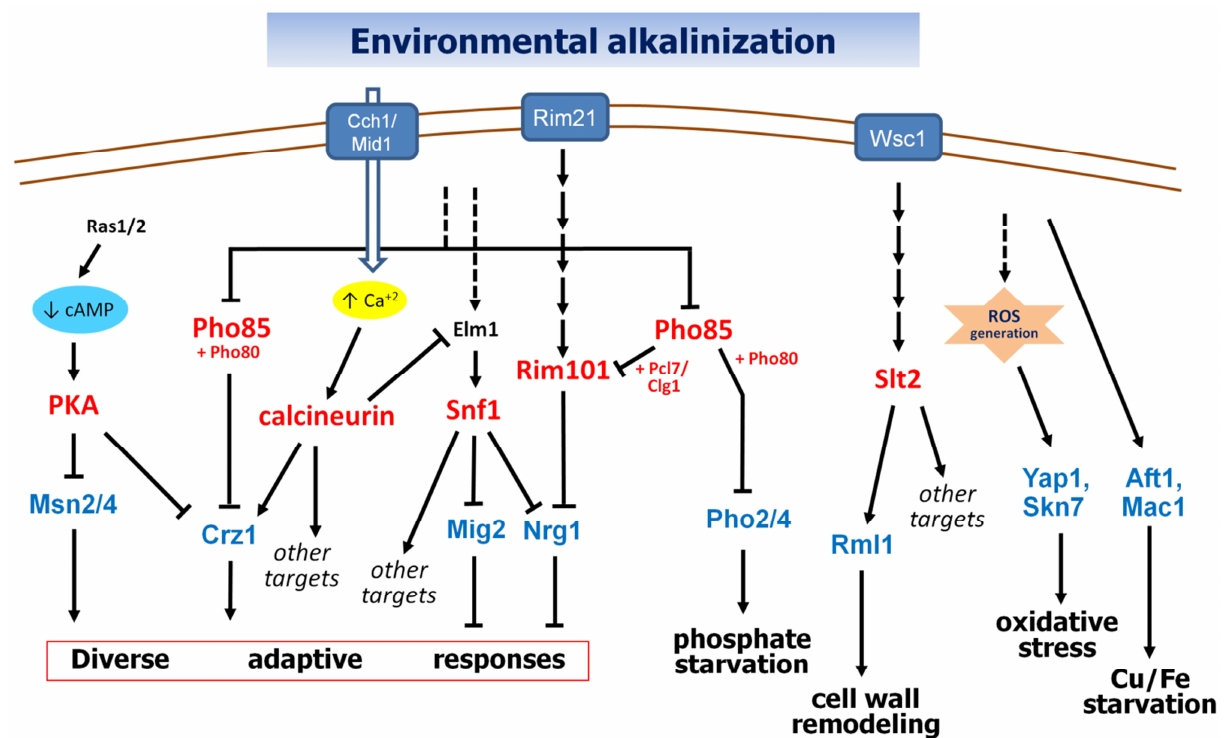
FIGURE 1: Known signaling pathways in alkaline pH response. Discontinuous lines denote still uncharacterized links. See text for